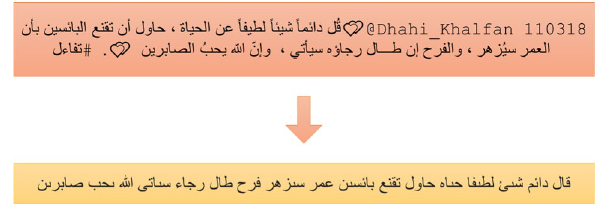
Fig. 3 Example tweet before and after